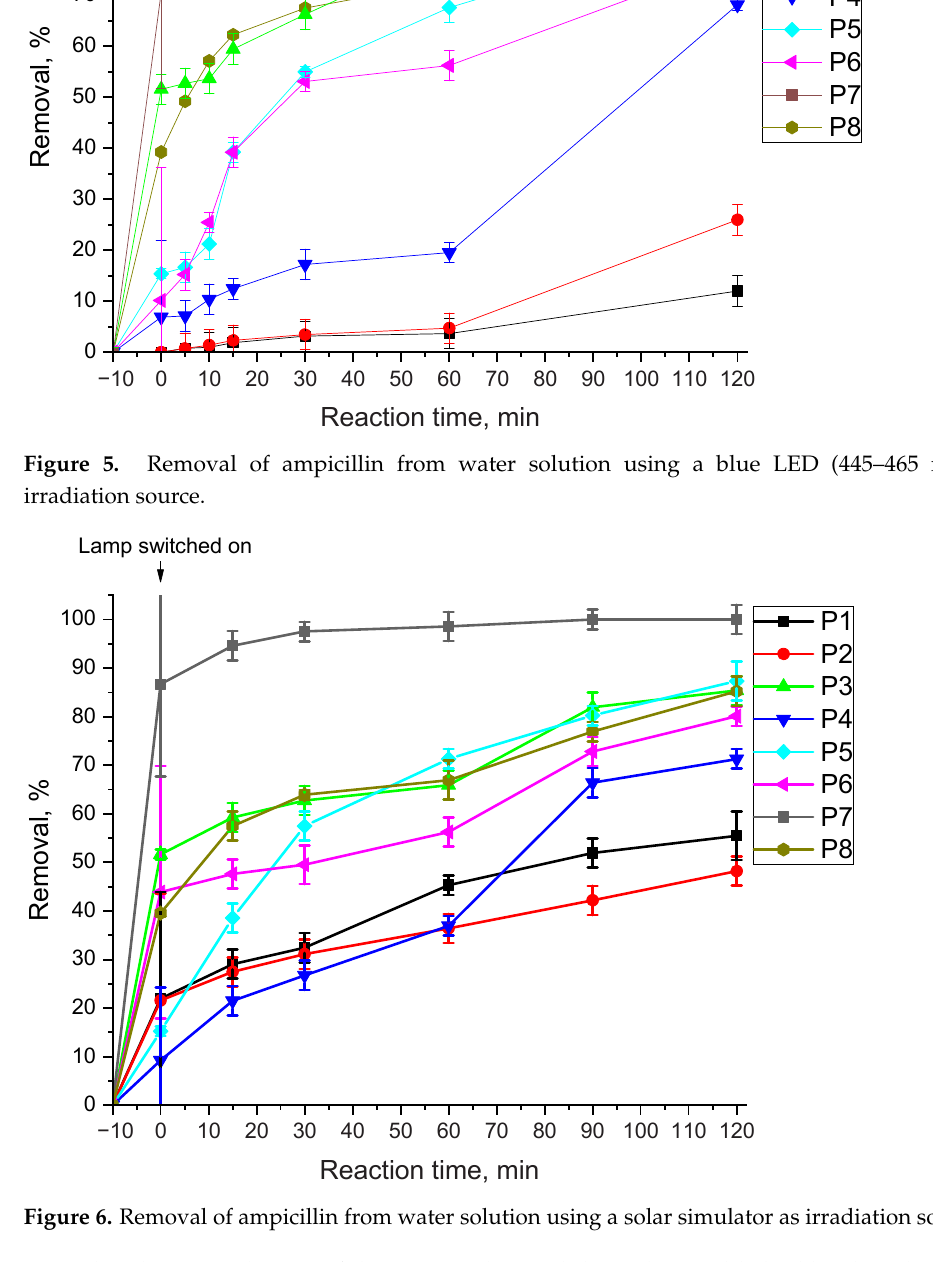
Figure 6. Removal of ampicillin from water solution using a solar simulator as irradiation source.